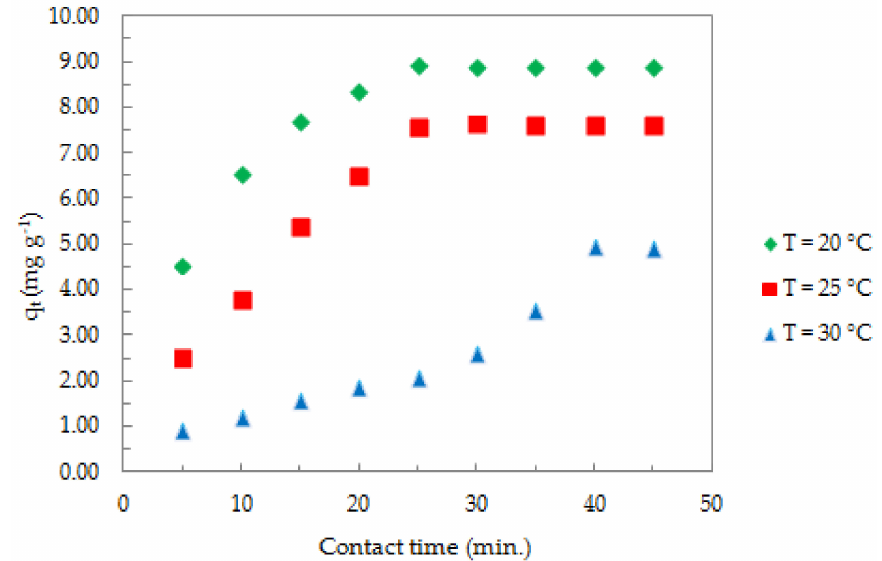
Figure 8. Effect of contact time and temperature on the adsorption of Sb (III) onto ox-xGnP (pH = 7.0, 1.0 mg L − 1 Sb (III), 1.0 mg of ox-xGnP/100 mL